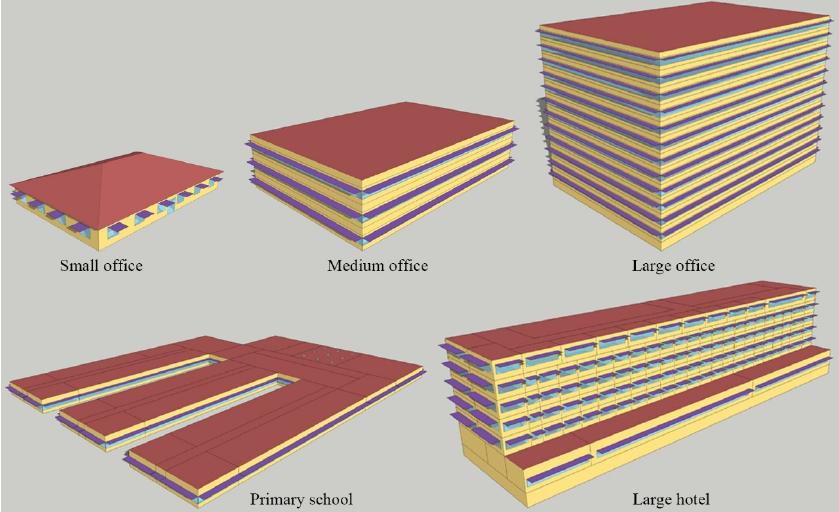
Figure 5. Architectural schematic views of the benchmark models. Table 1. Summary of the characteristics of the benchmark models.